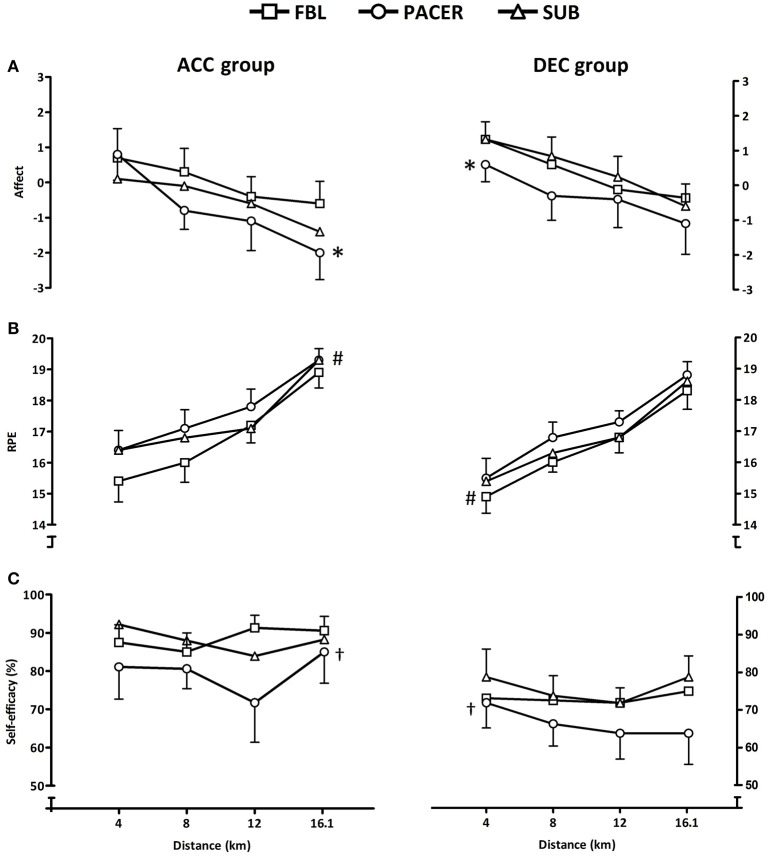
Mean (SEM) affect (A), RPE (B), and self-efficacy (C) responses at each distance quartile in 16.1 km time trials for the ACC and DEC groups. *Denotes significantly lower mean affect than FBL (P < 0.005). #Denotes significantly higher mean RPE than FBL and SUB (P < 0.005). †Denotes significantly lower mean self-efficacy than FBL and SUB (P < 0.005).